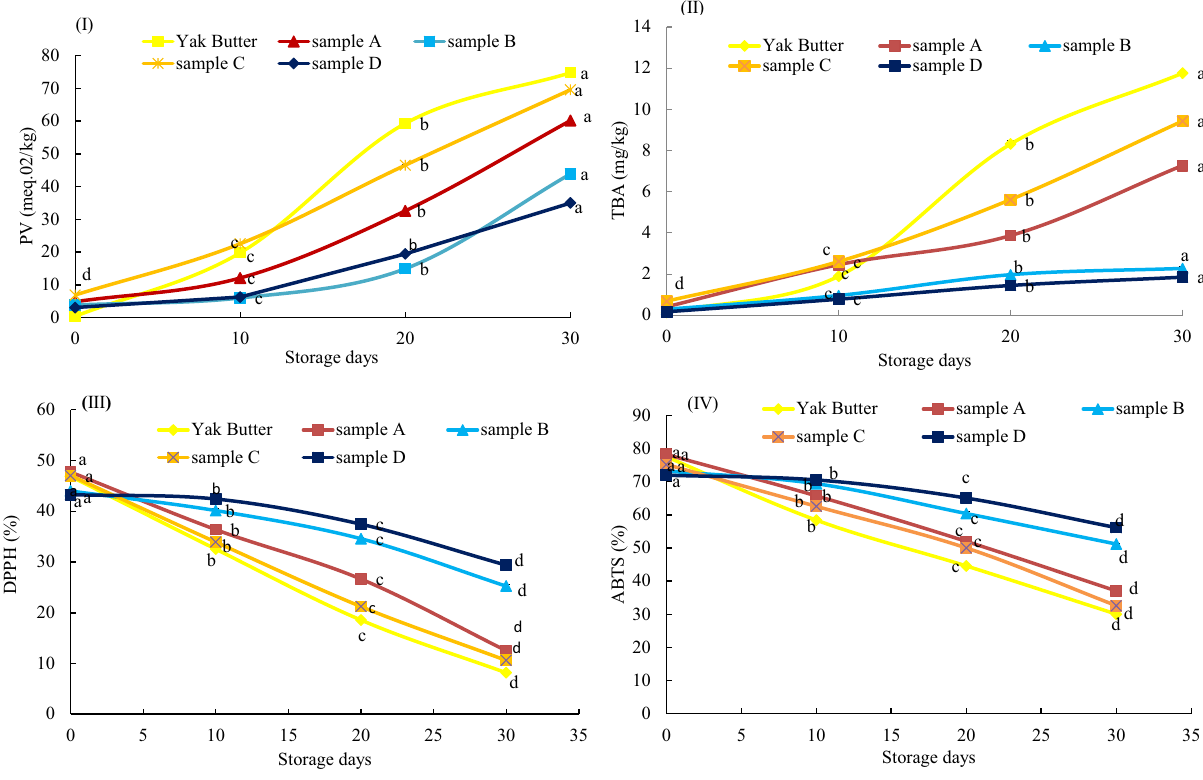
Figure 5. Changes in oxidation stability and radical scavenging activities of yak butter powders during accelerated storage. (1) Peroxide values (PV) (II) Thiobarbituric acid (TBA) test values (III) 2,2-diphenyl-1- picrylhydrazyl (DPPH) radical scavenging activity and (IV) 2,2’-Azinobis(3-ethylbenzothiazoline-6-sulfonic acid) (ABTS) test values. “a, b, c, d” indicate significant differences within yak butter powders at p <